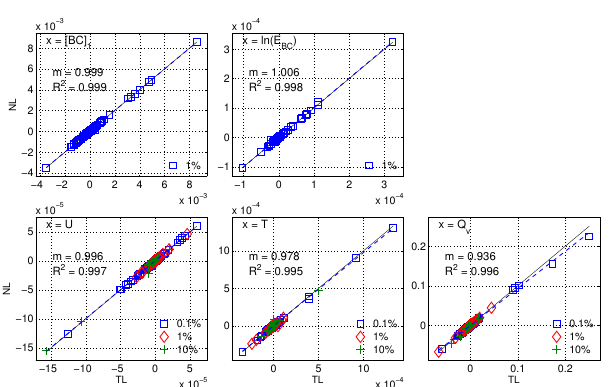
Figure 2. Comparison of nonlinear finite difference approxima- tions to TLM evaluations of ∂ [BC 1 ] and ∂ [BC 2 ] for 300 deriva- ∂ x ∂ x tives for each denominator variable. The different markers for x = [ U,T,Q v ] indicate the δx percentage that yielded a finite difference derivative closest to the tangent linear value. The slope ( m ) and R 2 statistic for the linear fit are shown for each